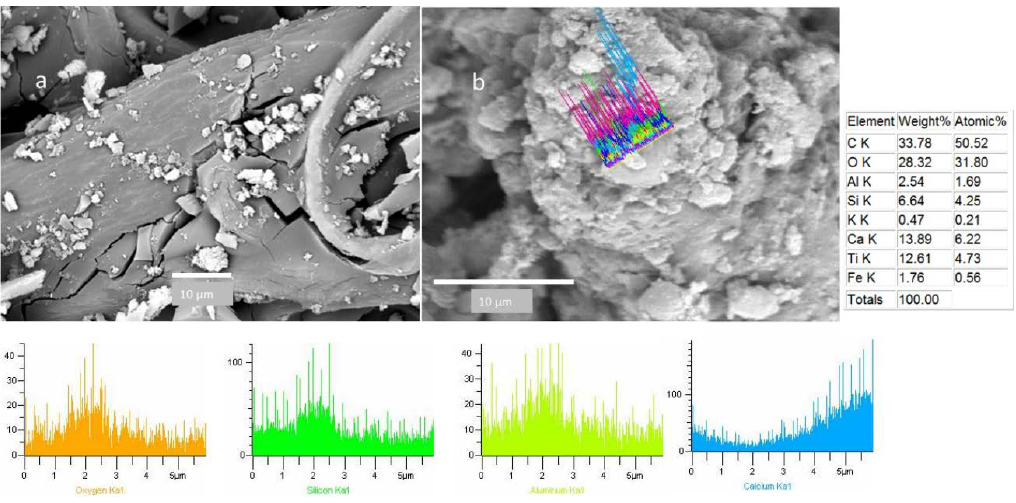
Figure 8. ( a ) Particles less than 2.5 µm and ( b ) nucleation and condensation of < 2.5 µm particles that were deposited on CAF.